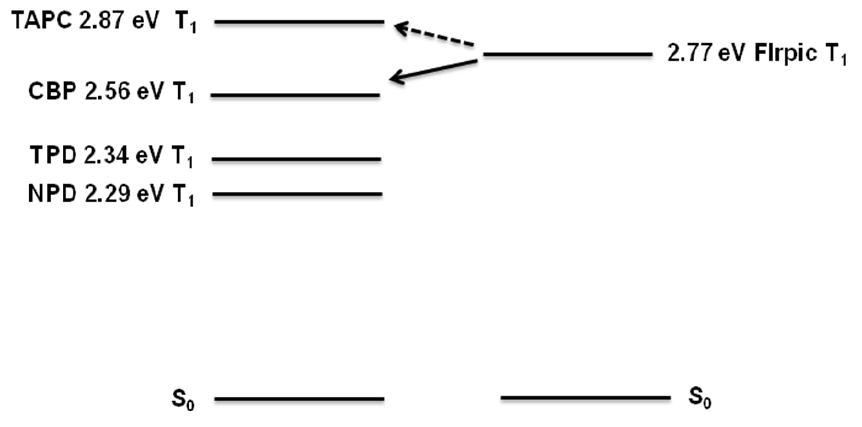
Figure 5. ( a ) EL spectra of the PHOLEDs; ( b ) EL spectra at 470 to 520 nm.